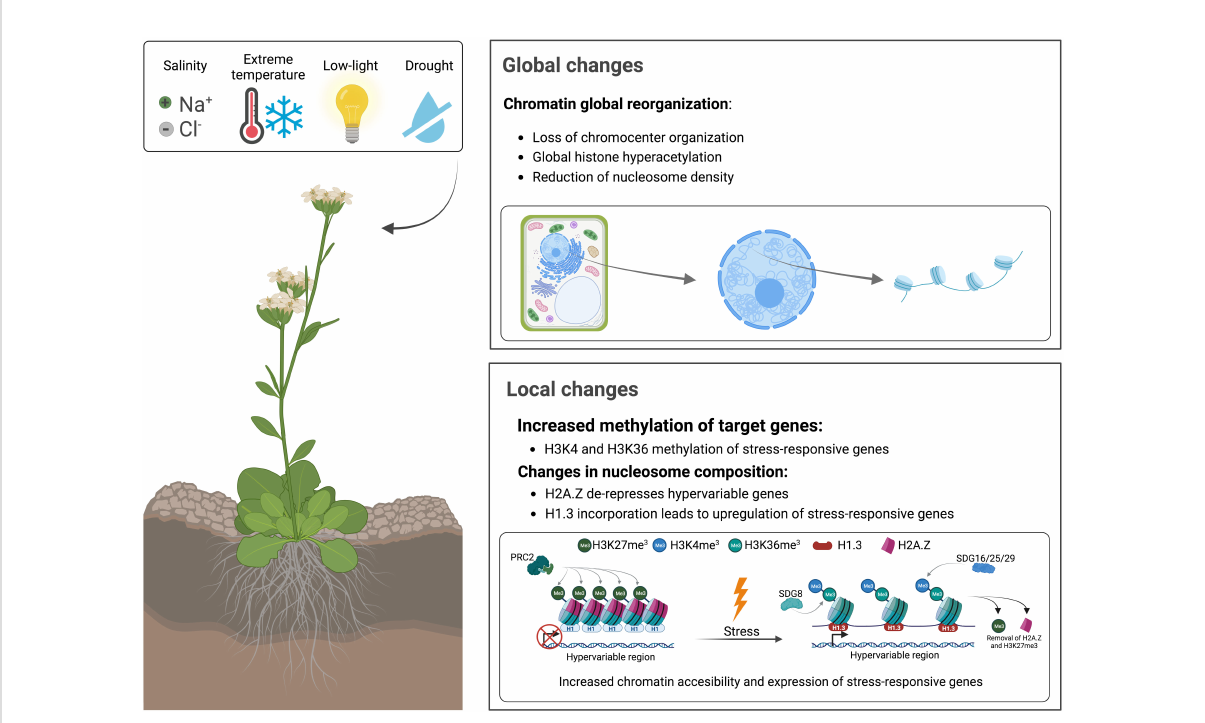
FIGURE 1 Global and local changes in chromatin structure in response to abiotic factors, such as salt, limited water availability, cold, heat, and low-light. Global changes are distributed genome-wide, whereas local changes are directed to speci fi c genomic regions, commonly associated with stress-responsive